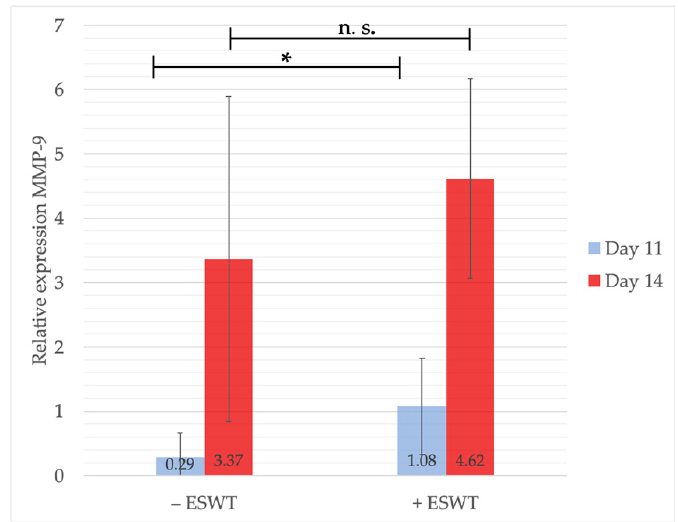
Figure 8. Gene expression analysis of MMP-9 via qPCR. The measurement on EDD-11 could show significantly higher levels in MMP-9 expression within the treated compared to the untreated group.